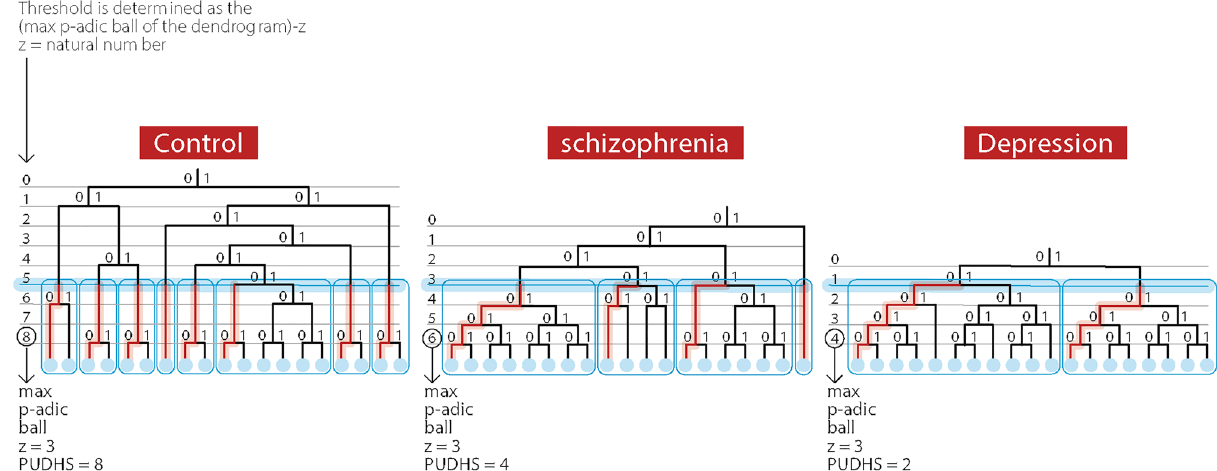
Figure 4. Illustration of dendrogramic topological differences between the control, schizophrenia, and depression groups. The max p-adic dendrogramic ball value is indicated by a circled level number on the left of each characteristic group dendrogram. The threshold, calculated as indicated (max p-adic ball of the dendrogram-Z), is seen as a thick blue horizontal line and creates disconnected subsystems (sub-dendrograms) of the main dendrogram. Each sub-dendrogram is encapsulated by a thin light blue square. The number of these sub-dendrograms, represent the PUDHS